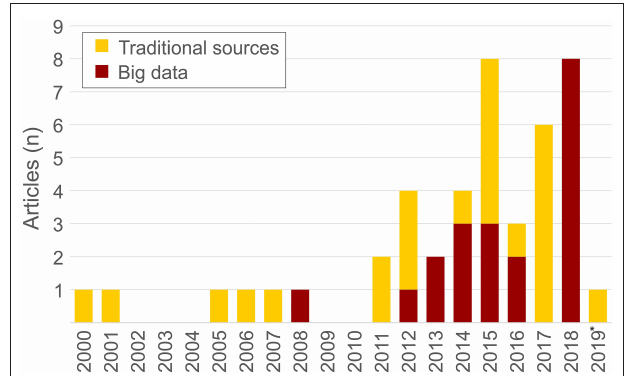
FIGURE 2 | The number of articles on quantitative activity space segregation research in the Scopus database by year and data source type ( n = 44).